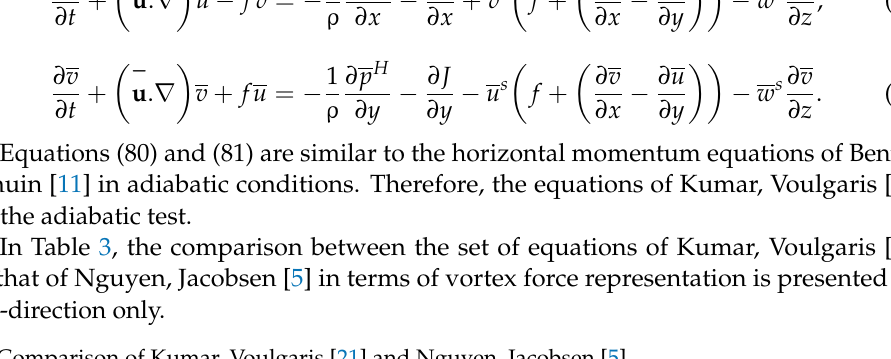
Table 3. Comparison of Kumar, Voulgaris [21] and Nguyen, Jacobsen